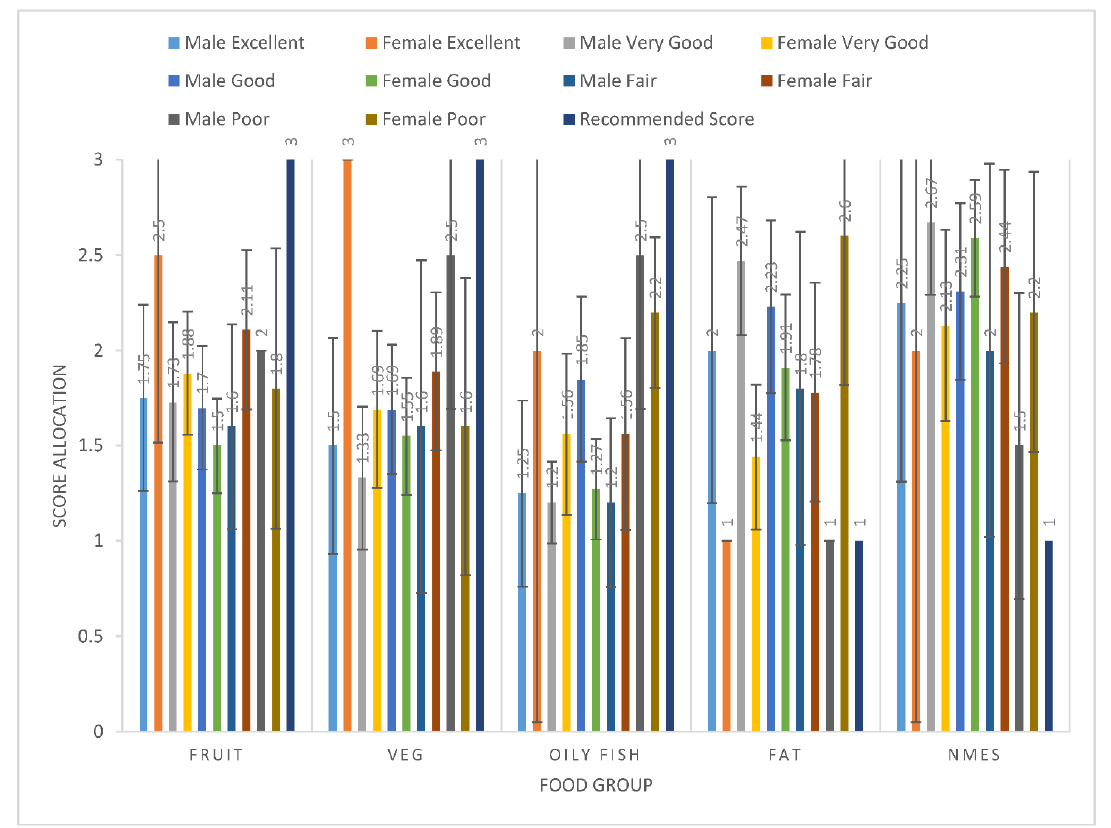
Figure 3. Mean food groups score allocation from the Short Form FFQ, evaluated using DANTE tool per sex and perceived healthiness levels compared to the recommended food groups scores.